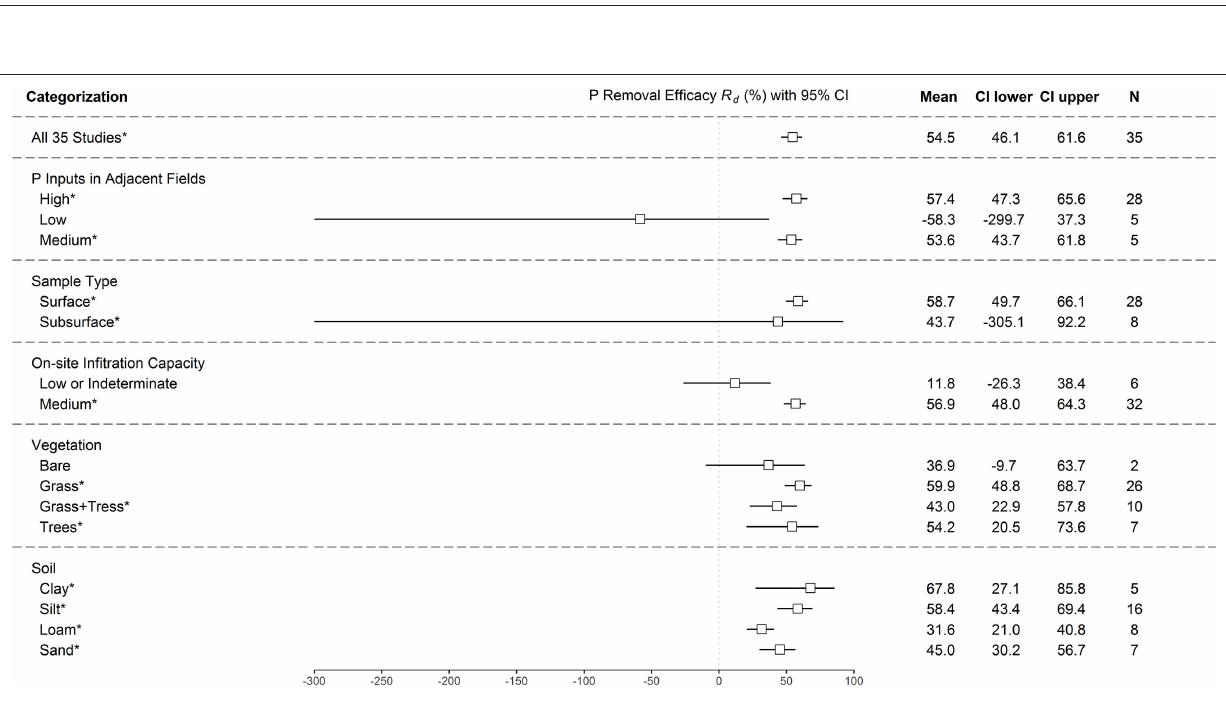
FIGURE 4 | Plot showing the mean and 95% confidence interval of P removal efficacy ( R d ) given multiple categorization schemes. Here, N represents the number of studies included in each category. * indicates between-study variance is significant.